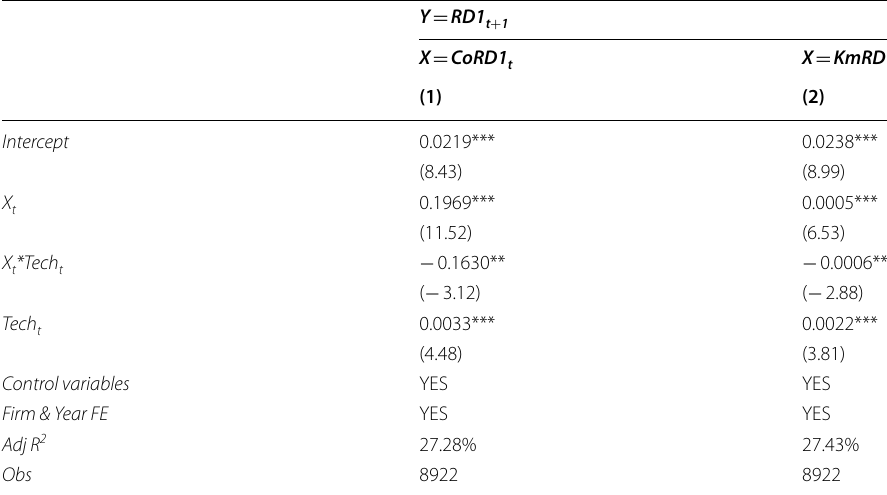
Table 9 Influence of R&D‑intensive to learning